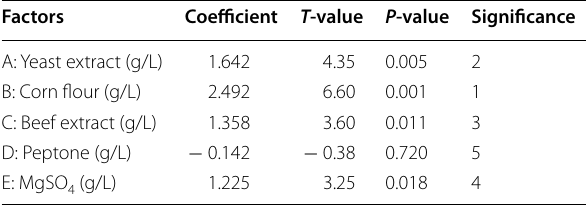
Table 2 The importance of each factor for medium optimization Factors